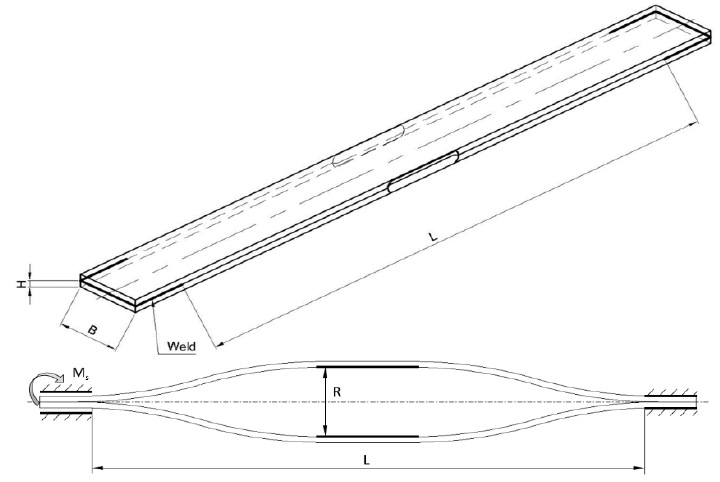
Figure 1. Schematic diagram of a test set (unexpanded on the top and expanded on the bottom).